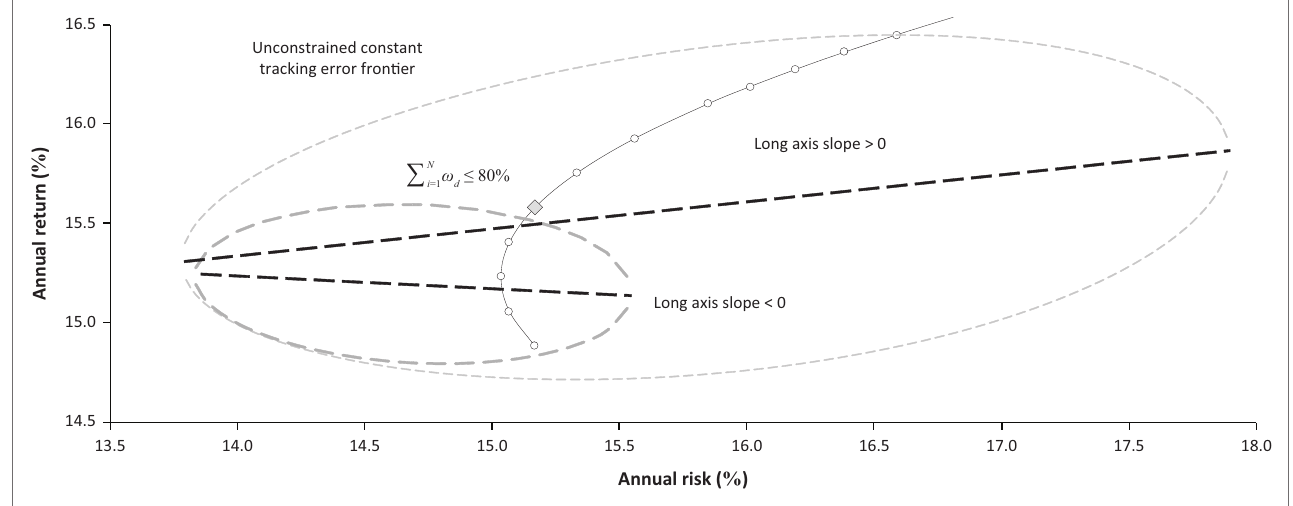
FIGURE 4: Sign of slopes of long axes for unconstrained constant TE = 5 % frontier and TE = 5 % frontier with domestic weights constrained to ≤ 80 %